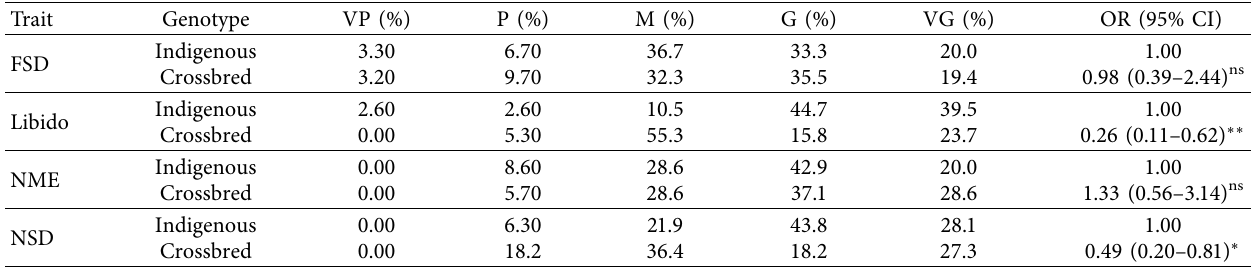
Table 3: Odds ratio estimate for reproductive traits of crossbred and indigenous bucks.